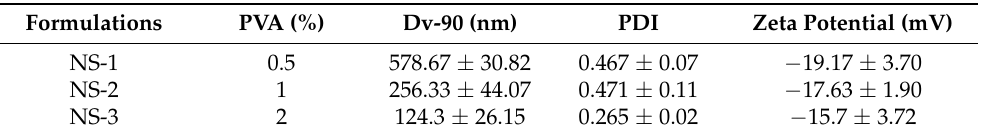
Table 2. Particle Size Distribution and Zeta Potential of Nanosuspension Formulations (n = 3, mean ±